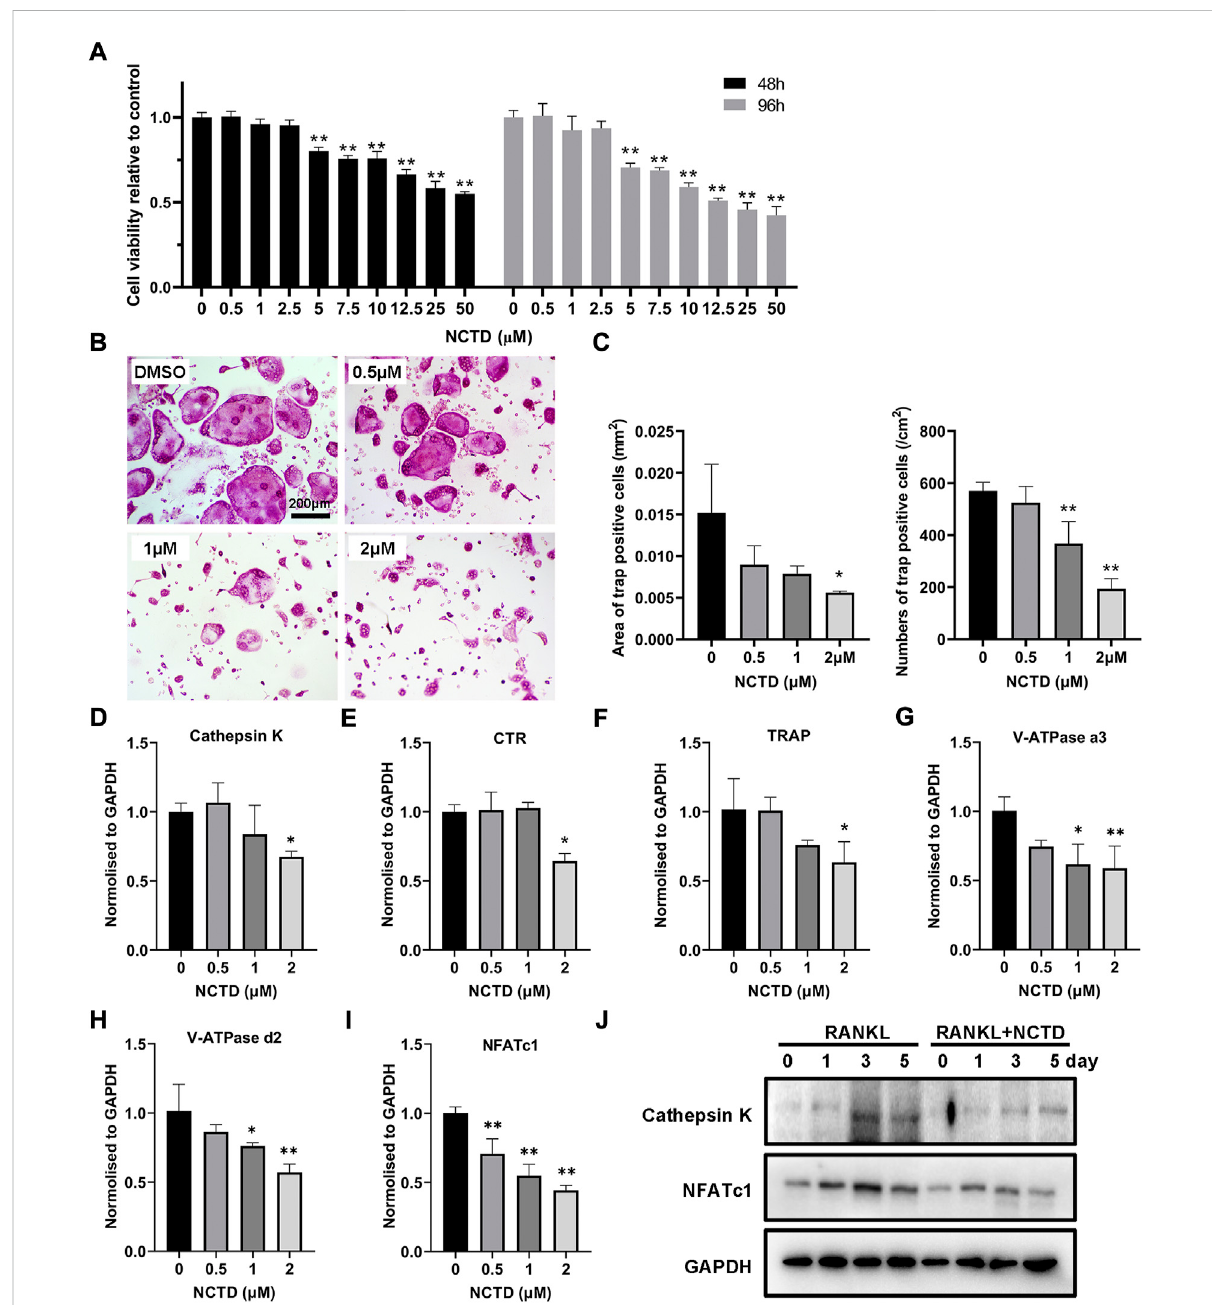
NCTD affected osteoclast formation in BMM in a non-toxic range. (A) After adding gradient concentration of NCTD into BMM cell culture, CCK8kit wasused to detect thecell viability to fi gure out thenon-toxic range ofNCTD for BMM ( n =5). (B) BMM cells wereinducedinto osteoclasts with cytokines M-CSF and RANKL, and DMSO/NCTD was added to observe the effect of NCTD on osteoclastogenesis. (C) The area and number of osteoclasts induced by BMM were quanti fi ed. (D – I) After BMM was treated with different concentrations of NCTD, the osteoclast makers of Cathepsin K, CTR, TRAP, V-ATPase a3, V-ATPase d2, and NFAT c1 were detected by fl uorescence quantitative PCR. (J) Western blotting was used to investigate the effects of NCTD addition on Cathepsin K and NFATc1 during osteoclast formation. All experiments were repeated independently for three times. Values are expressed as mean ± SD; * p < 0.05, ** p < 0.01 vs. the control